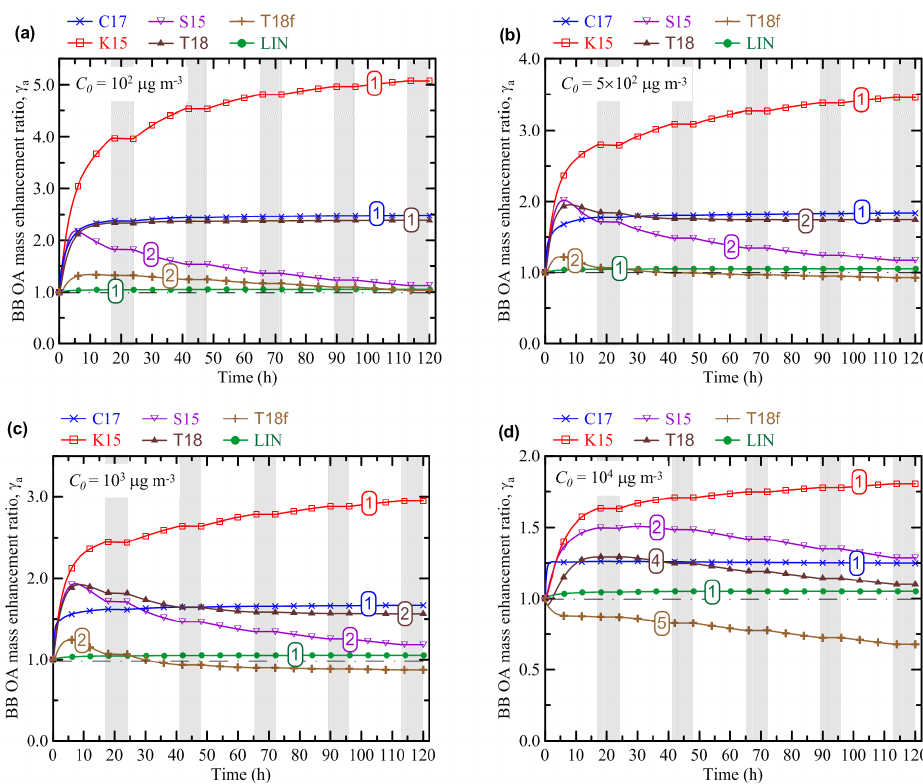
Figure 3. Evolution of the BB OA mass enhancement ratio ( γ a ) according to the simulations performed with the different OA schemes and with different values of the initial mass concentration of BB OA: (a) C 0 = 10 2 µgm 3 , (b) C 0 = 5 × 10 2 µgm 3 , (c) C 0 = 10 3 µgm 3 , and (d) C 0 = 10 4 µgm 3 . The initial BB plume size, S p , was fixed at 5km in all the simulations shown. Shaded bands depict nighttime periods when no oxidation reactions were allowed to occur. The numbers on the curves denote the different dynamical regimes of BB OA evolution according to the definitions in Sect. 3.1. A horizontal dashed–dotted line in each panel indicates the situation where no BB OA mass enhancement occurs ( γ a =